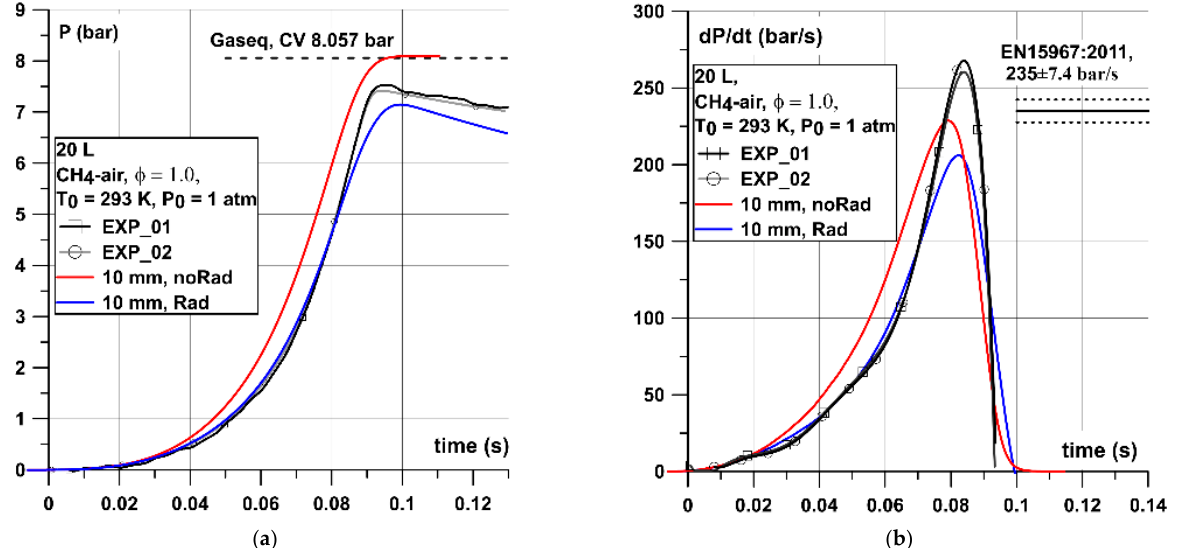
Energies 2021 , 14 , x FOR PEER REVIEW Figure 8. ( a ) Pressure and ( b ) dP/dt graphs for stoichiometric CH 4 –air mixture in the 0.02 m 3 vessel. Figure 8. ( a ) Pressure and ( b ) dP/dt graphs for stoichiometric CH